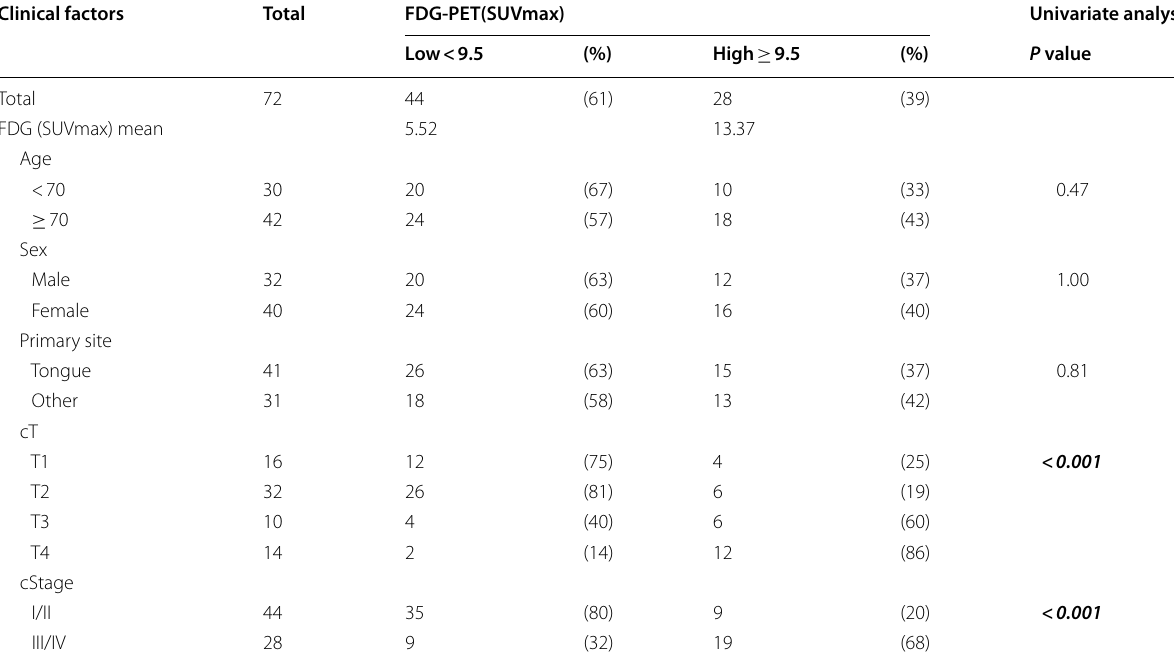
Statistically significant <0.05 is in bolditalic